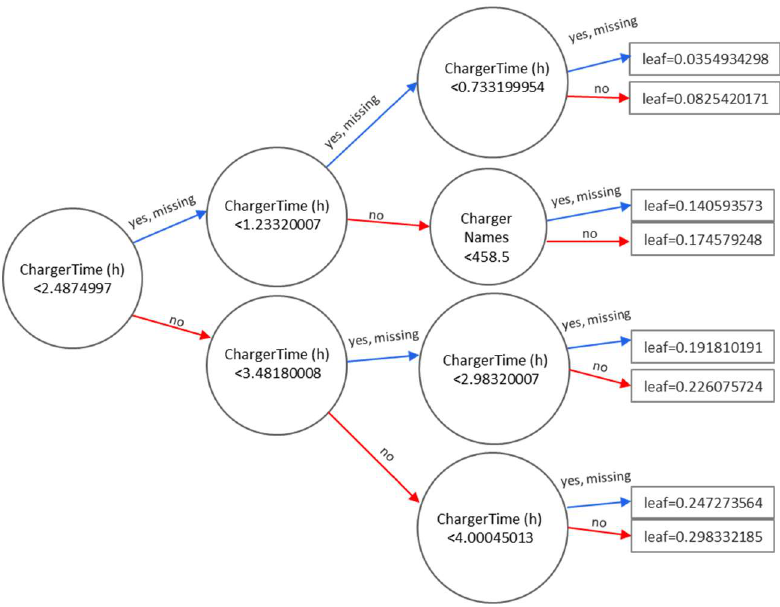
Energies 2019 , 12 , x FOR PEER REVIEW Figure 4. First XGBoost Tree example with depth of three layers. Figure 4. First XGBoost Tree example with depth of three layers.